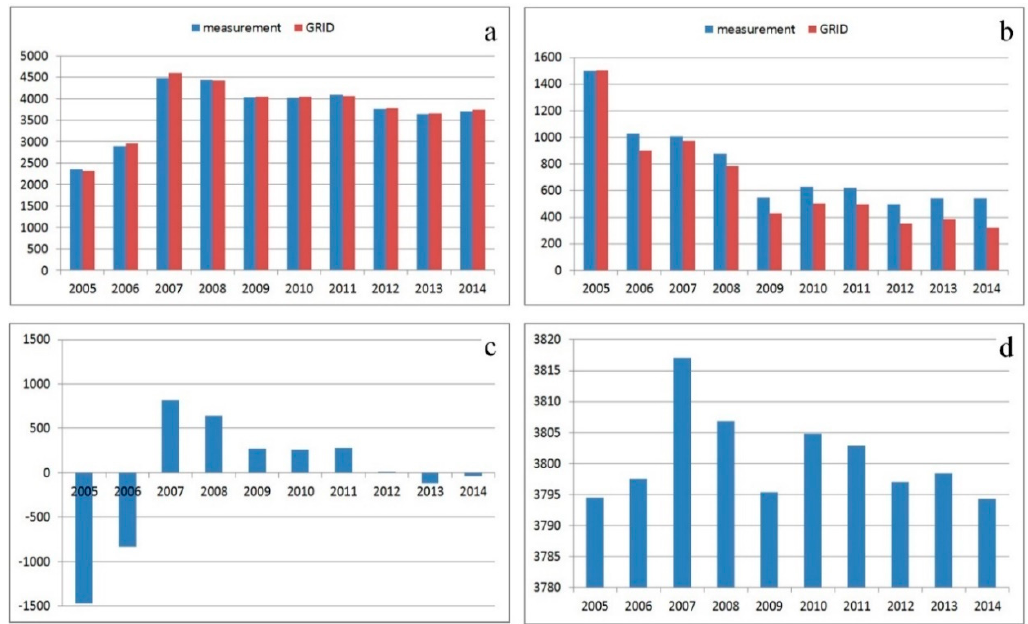
Figure 10. Statistical indicators calculated in successive years between the value interpolated in a given epoch and the value determined by the average for the entire analyzed period; ( a ) comparison of the absolute value of the average computed from measured data and from GRID nodes; ( b ) comparison of RMSE from measured data and from GRID nodes; ( c ) comparison of the average difference between GRID nodes; ( d ) comparison of the standard deviation of values in GRID nodes. Source: own elaboration.